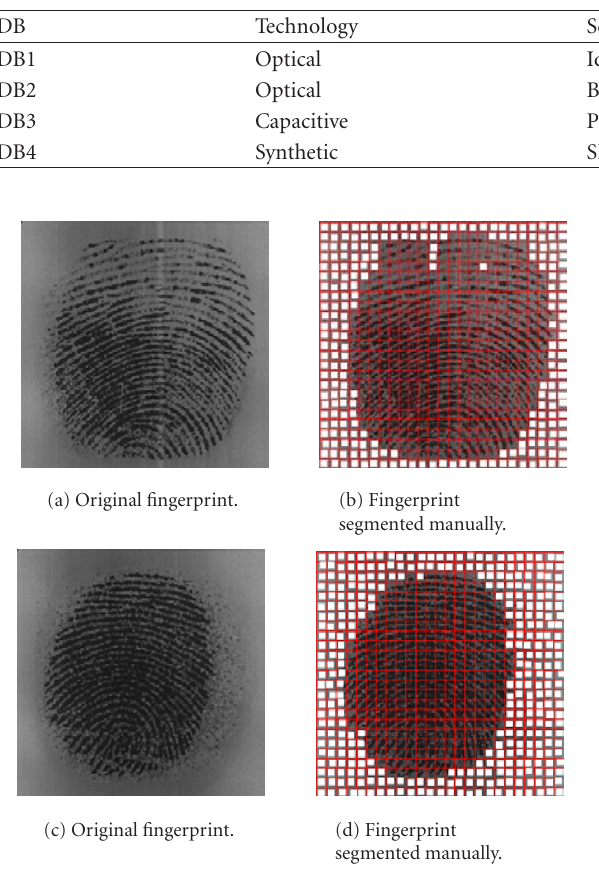
Figure 3: Two examples of fingerprints and segmented fingerprints of DB3.